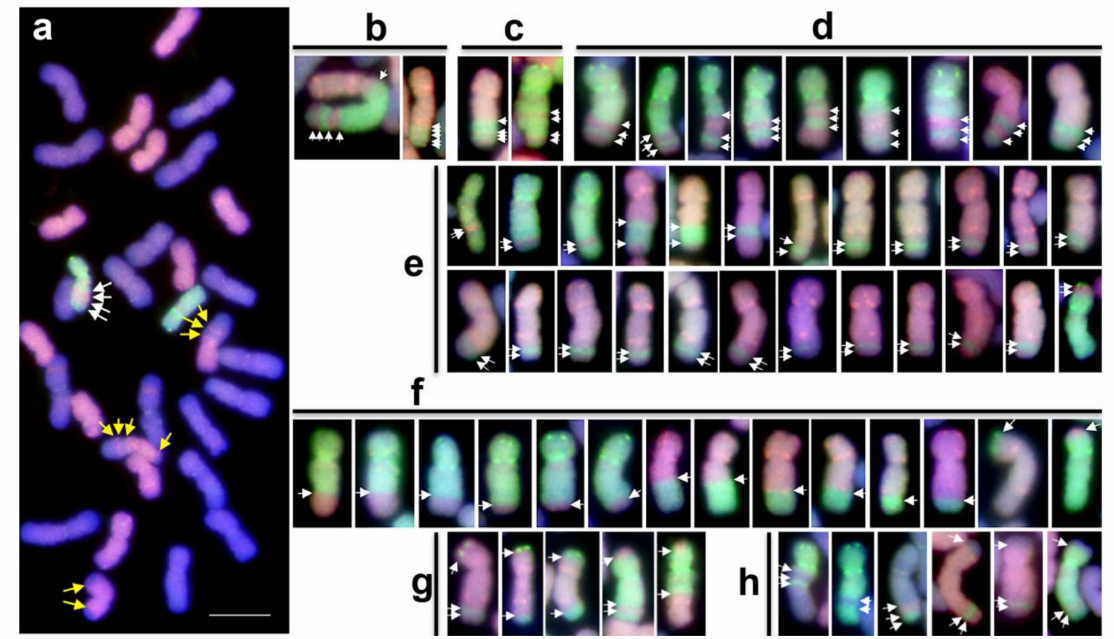
Figure 1. Genomic in situ hybridization (GISH)-based identification of recombinant chromosomes derived from plants with 5M g #1 and without Ph1 ( Hpp-5M g / ph1bph1b ). ( a ) A partial mitotic metaphase cell having 4 recombinant chromosomes derived from homoeologous recombination between 5Mg#1 and 5D (white arrows), and between the wheat subgenomes (yellow arrows). ( b – f ) Recombinants with five ( b ), four ( c ), three ( d ), two ( e ), and one CO sites ( f ); ( g ) recombinants with COs in both the short and long arm; ( h ) recombinants derived from multiple homoeologous recombination events between 5M g #1 and 5D, 5A, and 5B of wheat. A total of 63 recombinant chromosomes involving 5M g #1 were identified, out of 57 plants screened. COs sites are indicated by arrows. 5M g #1 is visualized in green, 5D in red, and 5A or 5B in blue fluorescence. Bar = 10 µ